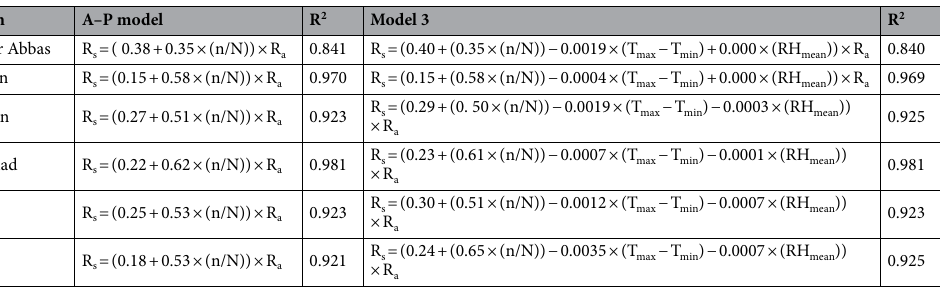
Table 7. Original equations obtained in this research for the estimation of solar radiation by SCE algorithm.